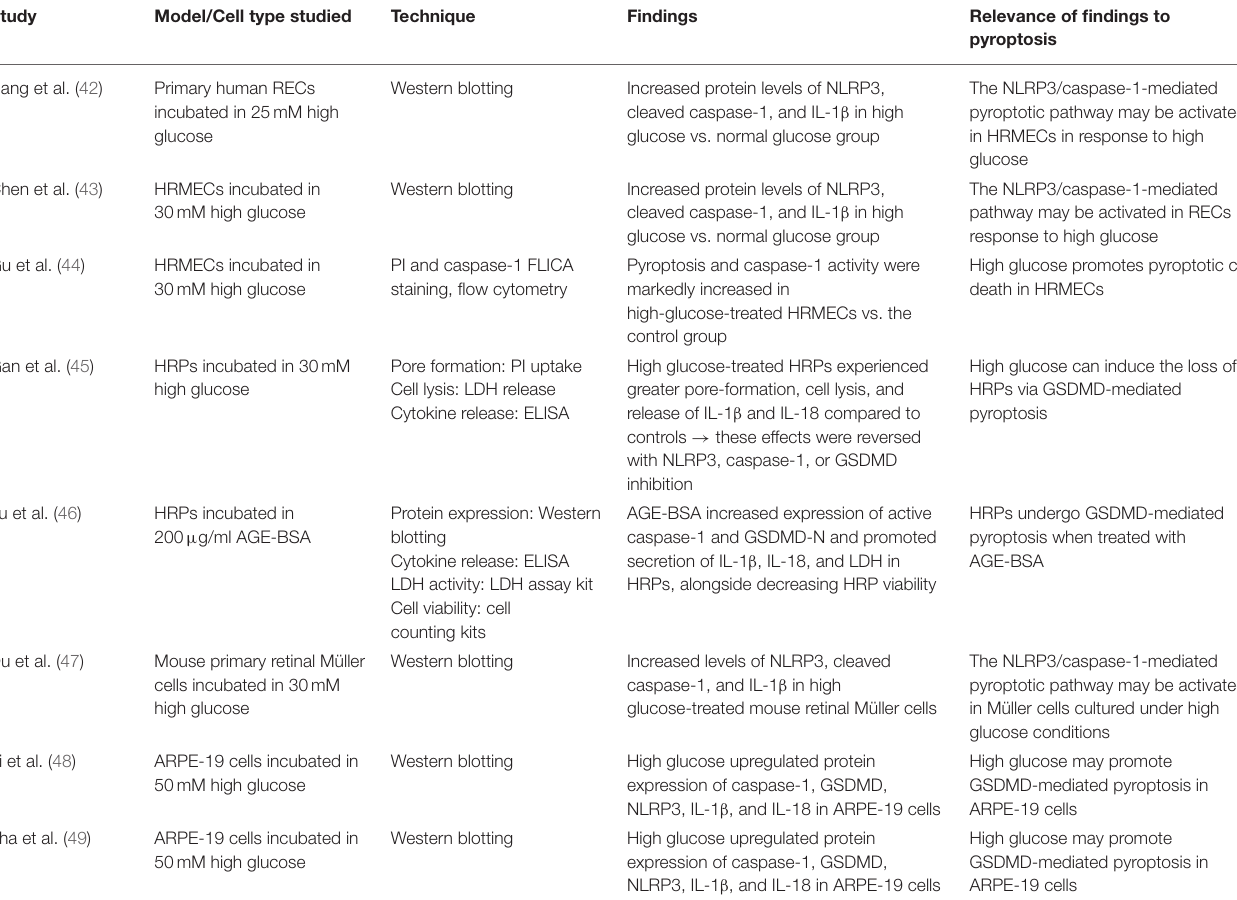
TABLE 2 | Studies investigating pyroptosis in